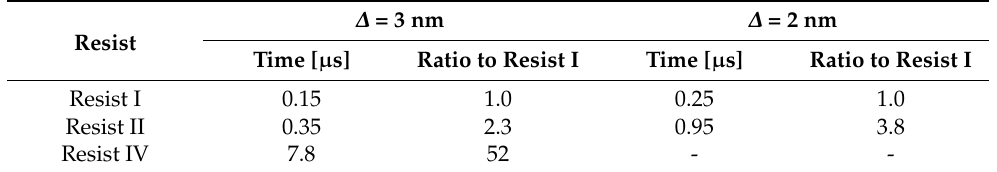
Table 3. Time required for complete filling and its ratio to resist I for trench widths ∆ of 2 and 3 nm for various